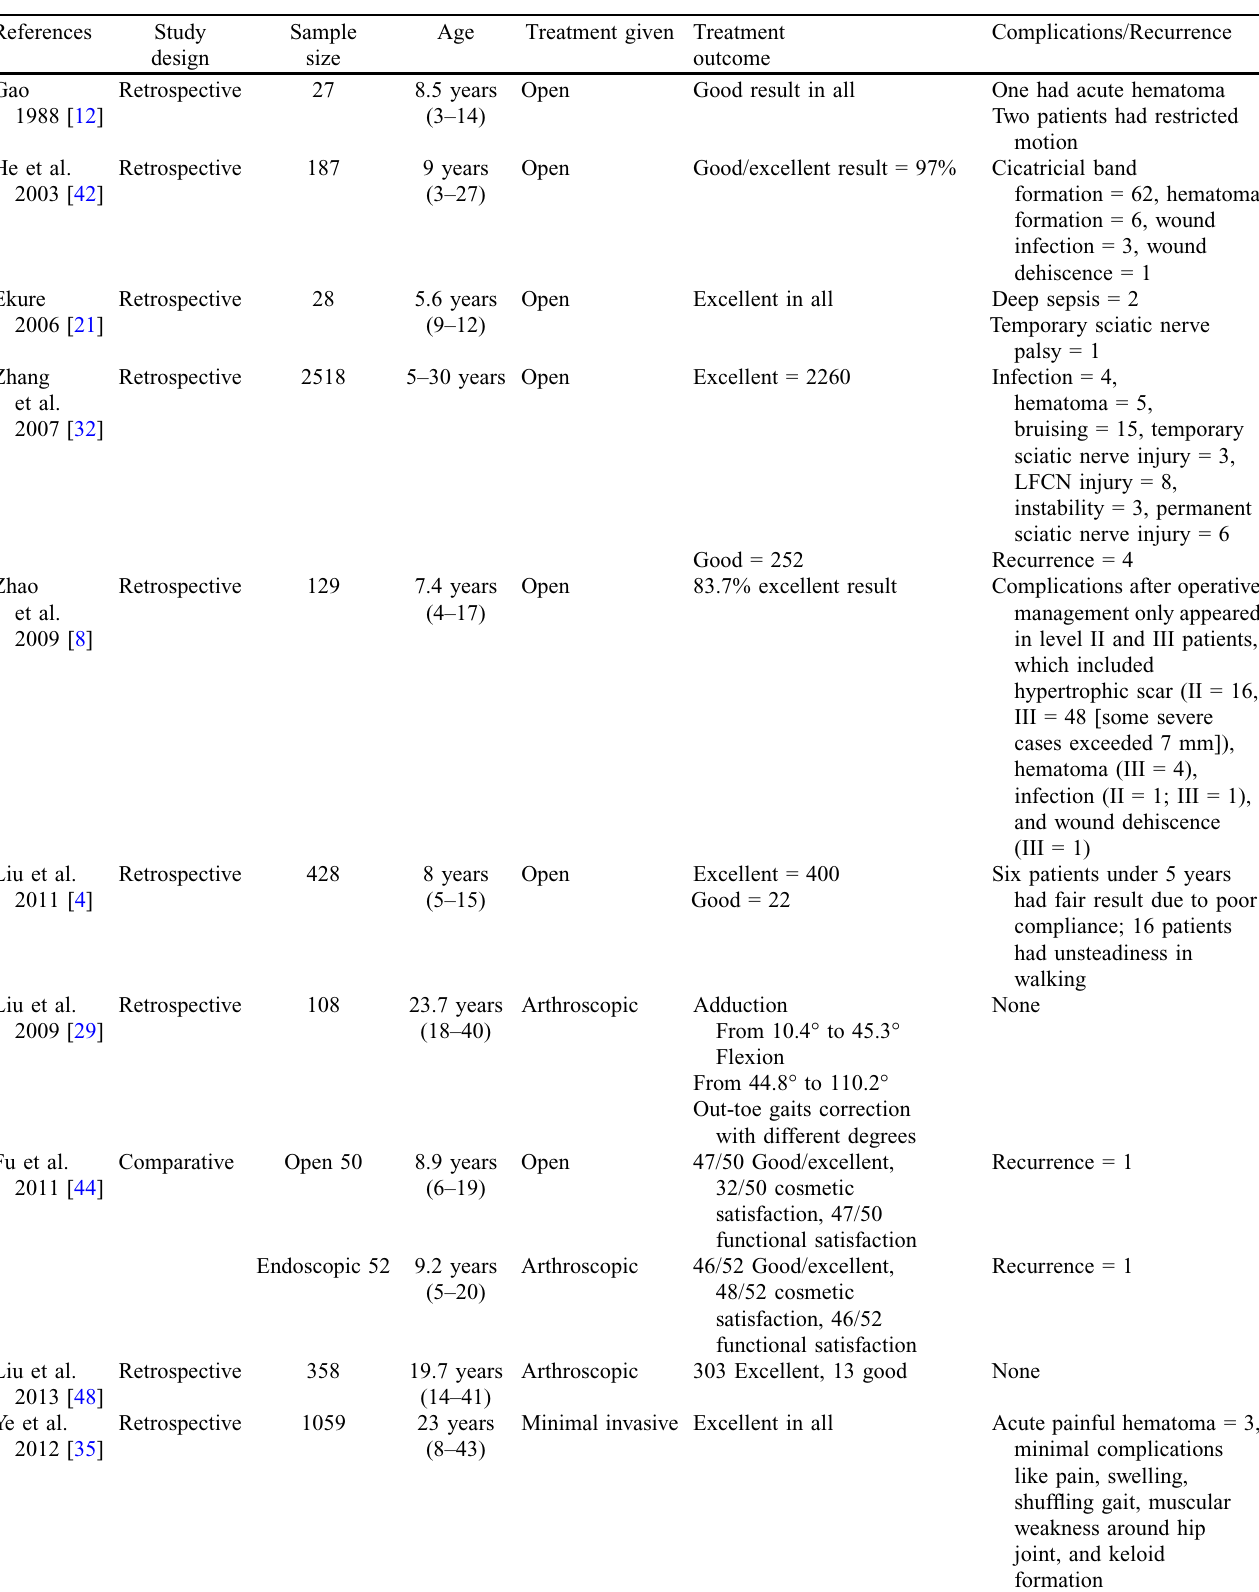
Table 3. Literature review of surgical options of gluteal muscle contracture and therapeutic